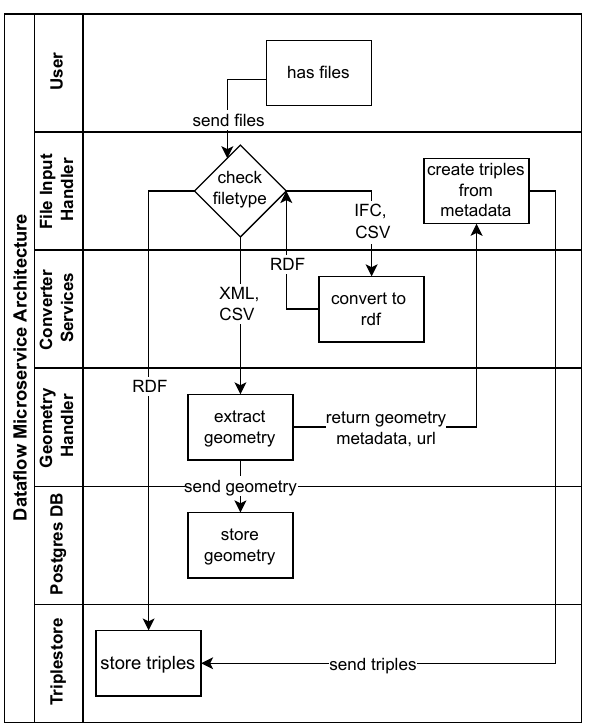
Figure 2. The Dataflow for data input through the